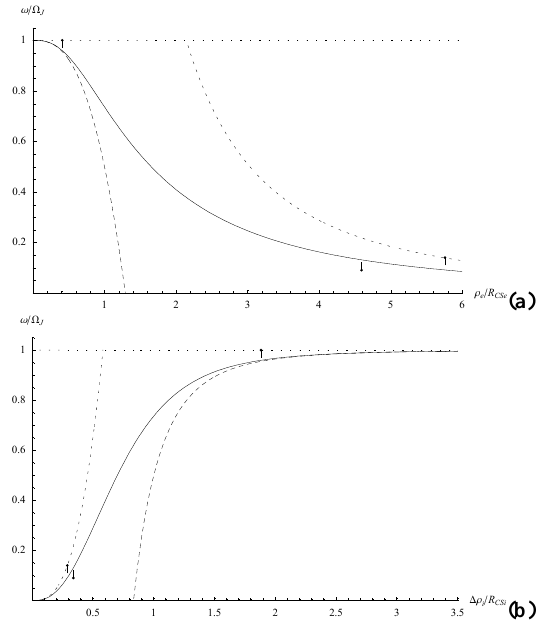
Fig. 6. Plots of the approximate analytic plasma angular velocity profile for the current sheet power law magnetic field model, given by Eq. (24) with m = 2 . 71, shown (a) versus (ρ e /R Cse ) in the equatorial plane, and (b) versus (1ρ i /R Csi ) in the ionosphere. The solid line in each case shows the full solution obtained from Eq. (28) with K = 0, such that the plasma rigidly corotates at small radial distances. The long-dashed lines show the small- ρ e (‘ S ’) form given by Eq. (32), while the large- ρ e (‘ L ’) form is just (ω/(cid:127) J ) L = 0. The downward-pointing tick marks indicate the limits of validity of both these approximations as defined for the dipole case shown in Fig. 2. The short-dashed lines show the higher-order large- ρ e (‘ L 0 ’) form given by Eq. (33), whose limit of validity (defined as for the dipole case) is indicated by the upward-pointing tick mark. The horizontal dotted line indicates the condition for rigid corotation, (ω/(cid:127) J ) =